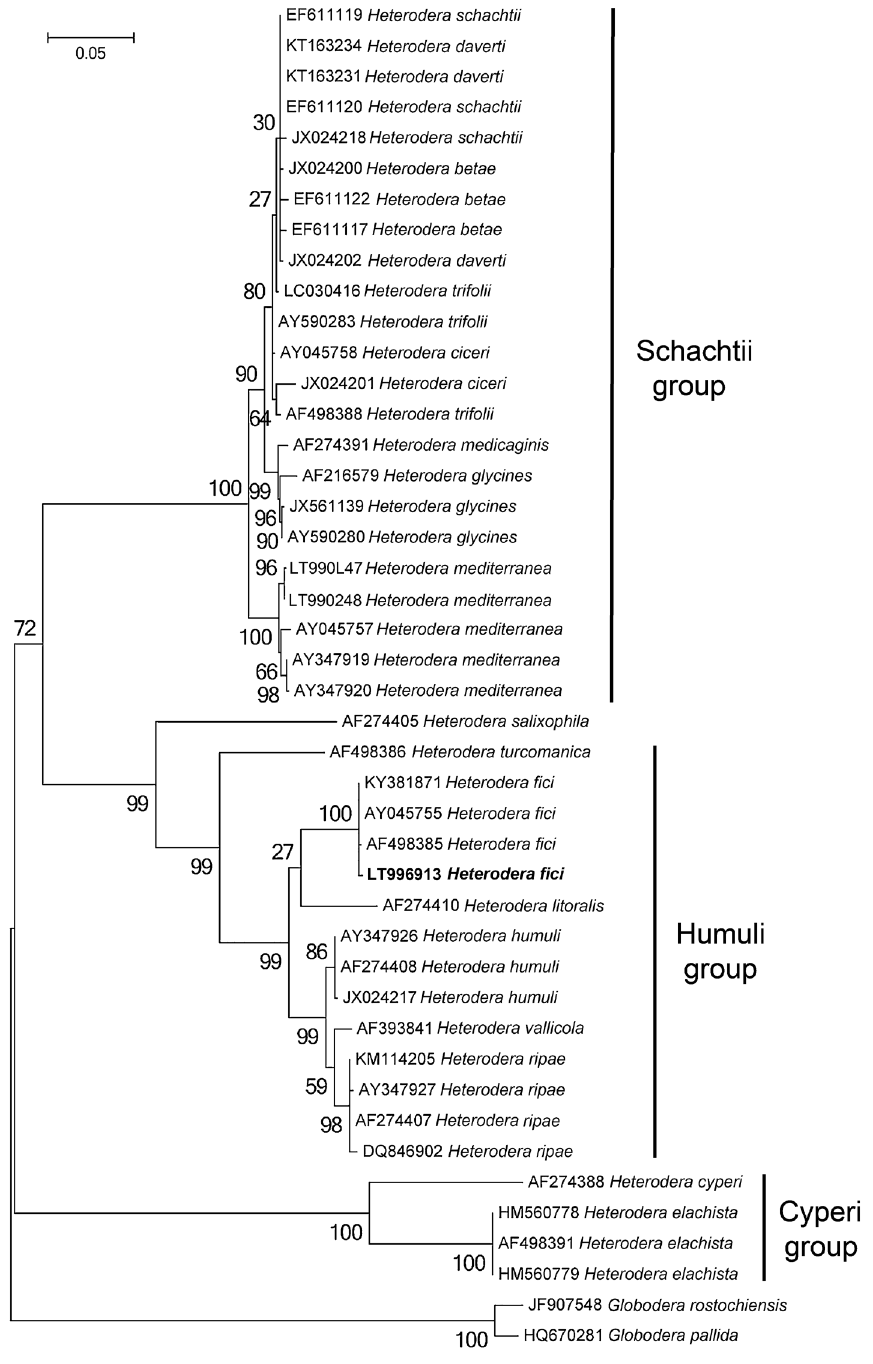
Figure 6. Phylogenetic trees of ITS containing region of Heterodera fici and the closest species. Sequences were analysed using the Maximum Likelihood method. Numbers at nodes indicate bootstrap